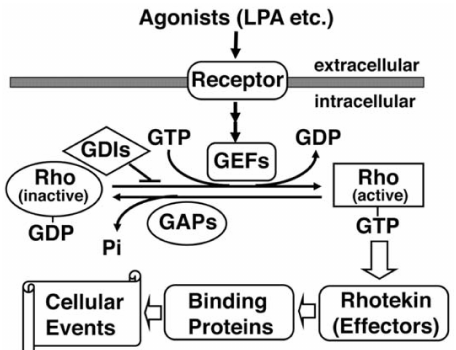
Figure 2. The supposed up and down-stream signaling paths of Rhotekin. Extracellular agonists such as lysophosphatidic acid (LPA) bind with a heterotrimeric G-protein-coupled receptor and activate specific GEFs (Guanine nucleotide exchange factors). GDI (GDP-dissociation inhibitor) selectively binds with the GDP-bound form of Rho and prevents the exchange of GDP for GTP. GEF catalyzes the exchange-bound GDP for GTP. The GTP-bound active Rho can interact with Rhotekin and may regulate the interaction between Rhotekin and its binding partners. GAP (GTPase activating protein) increases the intrinsic GTPase activity of Rho and causes the inactivation of the protein. Rhotekin may control various cellular events such as the proliferation of neural progenitor cells, the neurite outgrowth and the synapse